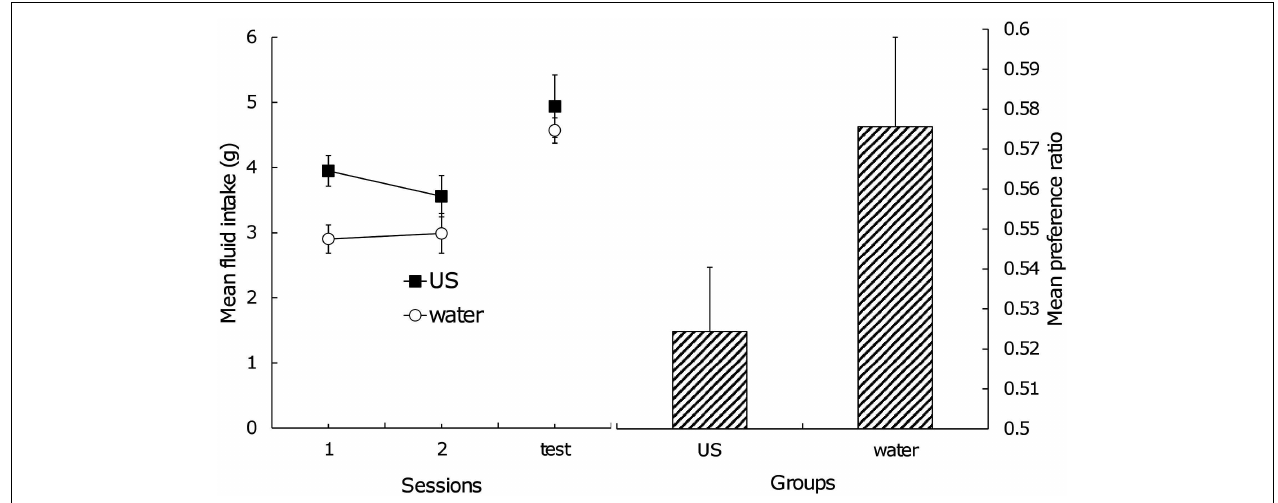
FIGURE 2 | Left: mean total intake of stimuli across US postexposure phase and test trial, Right: mean preference ratio for flavorA in test trial. Error bars indicate standard